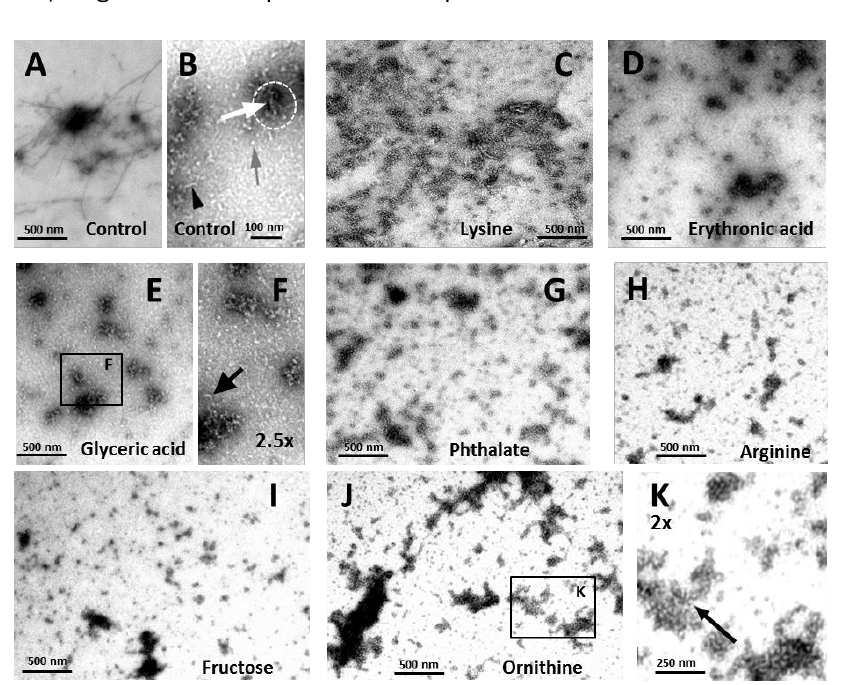
Figure 6. Metabolites modulate the morphology of apoSOD1 aggregates. TEM images of apoSOD1 with or without metabolites at a metabolite:protein ratio of 4, after incubation at pH 7.4 under agitation at 37 °C for 200 h. ( A , B ) Control, apoSOD1 with no added metabolite; ( C ) +lysine; ( D ) +erythronic acid; ( E ) +glyceric acid; ( F ) +glyceric acid, magnification of panel E; ( G ) +phthalate; ( H ) +arginine; ( I ) +fructose; ( J ) +ornithine; ( K ) +ornithine, magnification of panel J. See experimental section for further